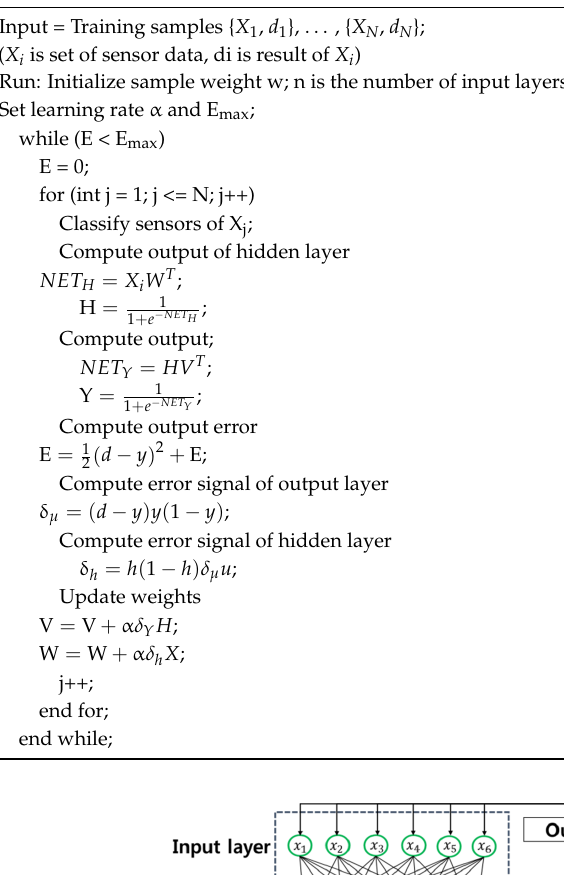
Algorithm 1 APDS learning method